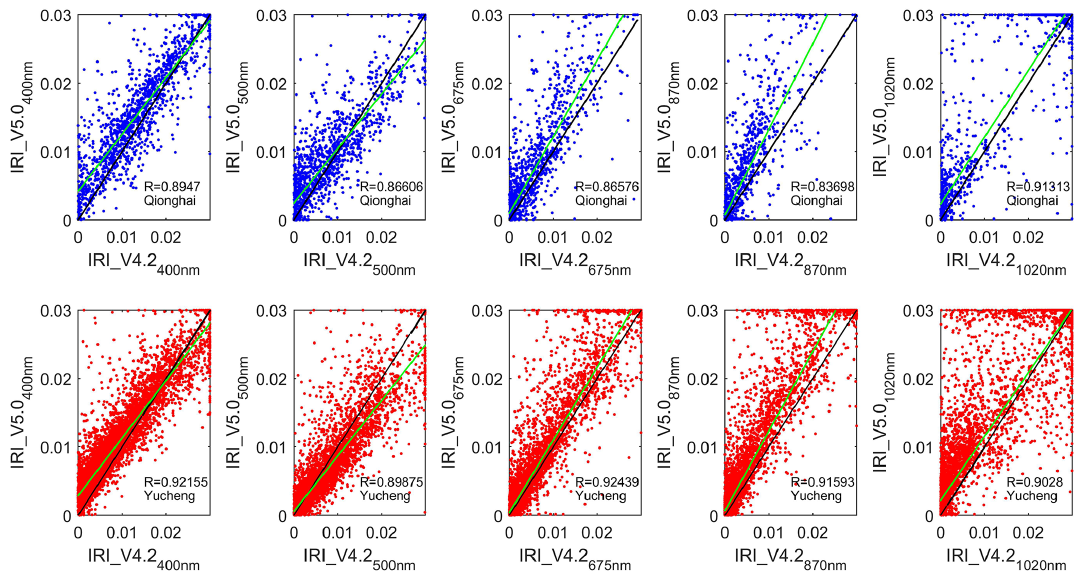
Figure 7. Scattergrams of the imaginary part of the complex refractive index ( m i ) retrieved by SKYRAD V4.2 and V5.0 at wavelengths of 400, 500, 670, 870, and 1020nm over Qionghai and Yucheng during February 2013 to December 2015. The green line indicates the fitted linear regression curve.